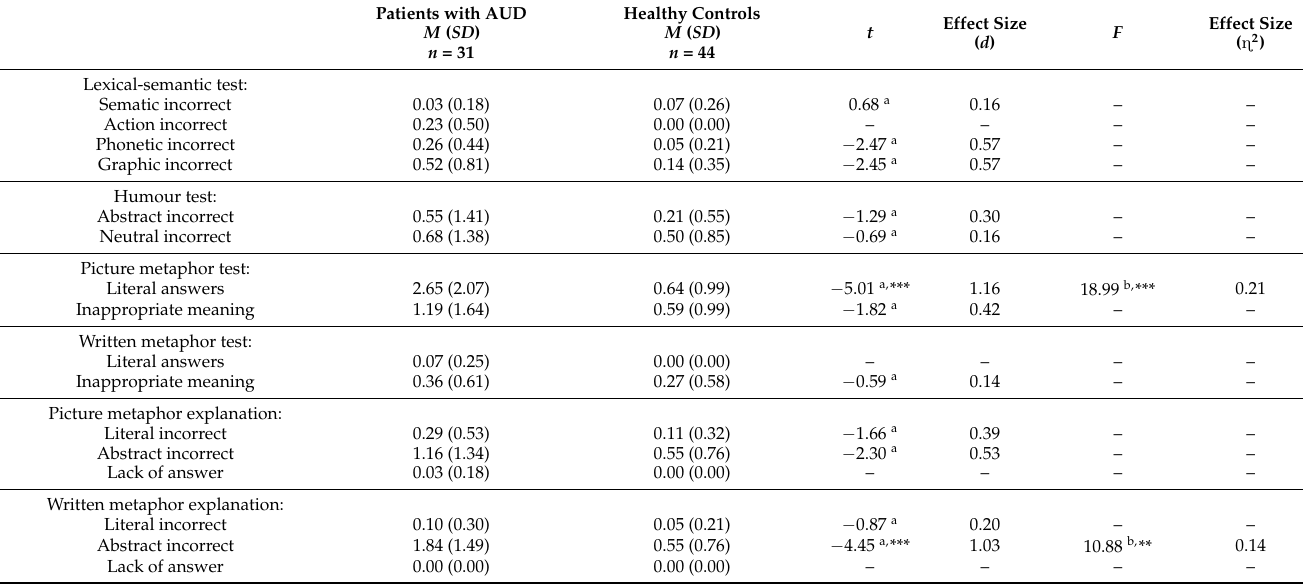
Table 3. Differences in incorrect answers in Right Hemisphere Language Battery (RHLB) between patients with alcohol use disorder (AUD) and healthy